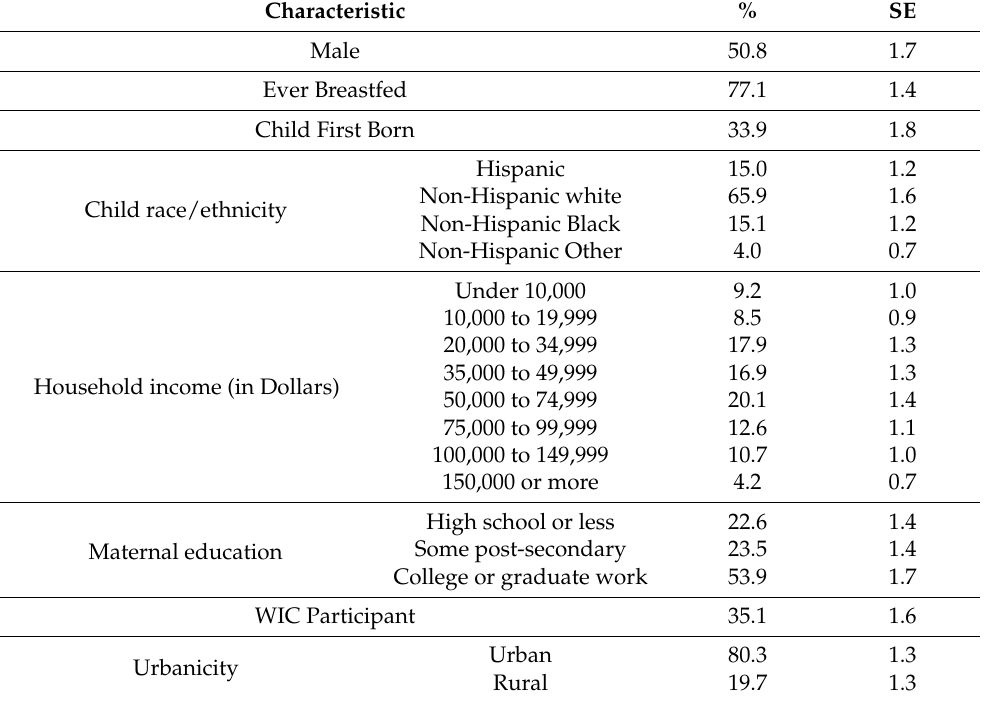
Table 2. Unweighted distributions and selected estimates (percent and standard error) among children aged 12–23.9 months not receiving breast milk or formula from the Feeding Infants and Toddlers Study 2016 ( n =